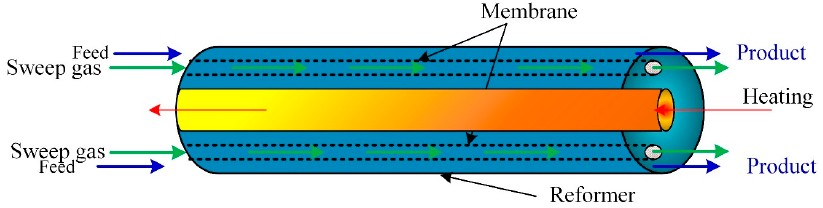
Figure 2. Schematic of a membrane reactor with multiple membrane tubes [47].